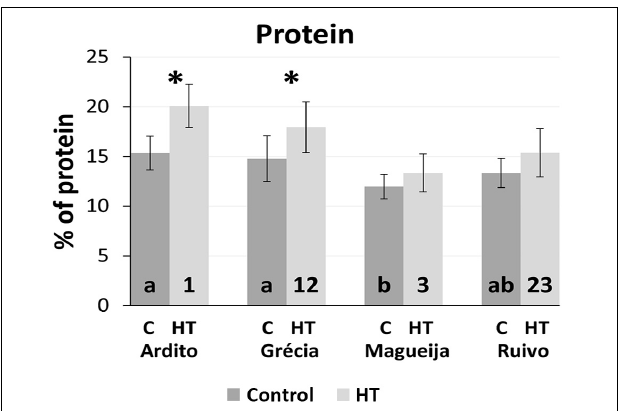
FIGURE 4 | Mean protein content of plants kept in control conditions (dark gray) and HT-treated (light gray) and respective standard deviations (represented as bars). Different letters and numbers inside columns indicate ANOVA significant differences between varieties in control and treatment conditions (HT), respectively. * t-test statistical differences between control and treatment in each variety ( p <